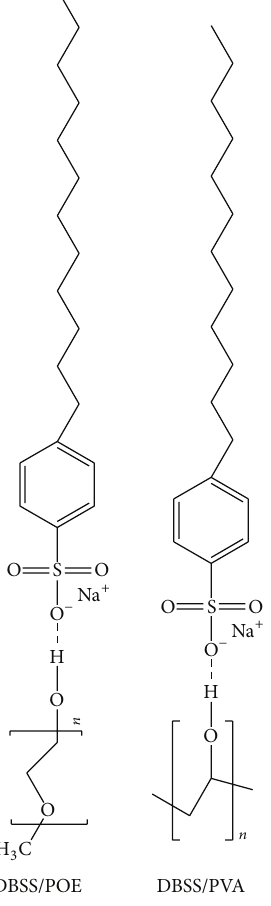
Scheme 2: Formation of hydrogen bond between DBSS and POE and